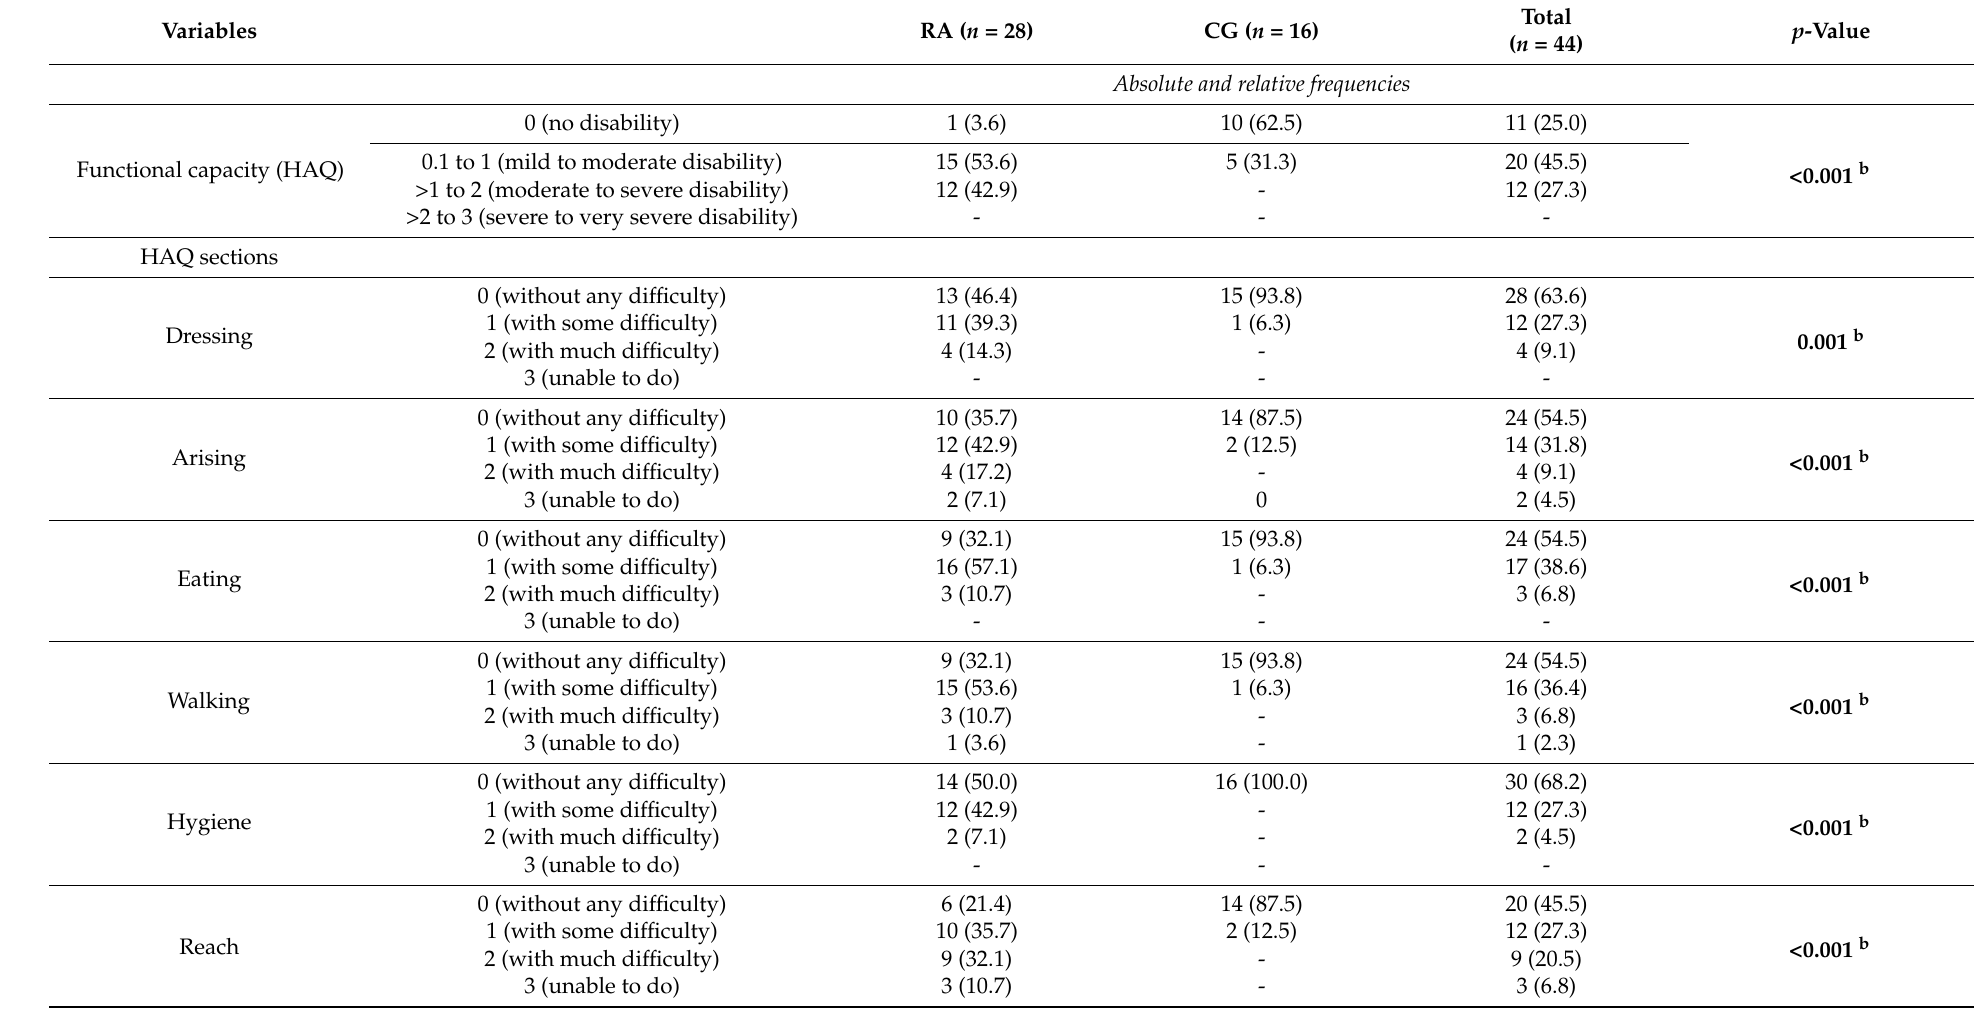
Table 3. Functional capacity, self-reported number of falls, and balance confidence